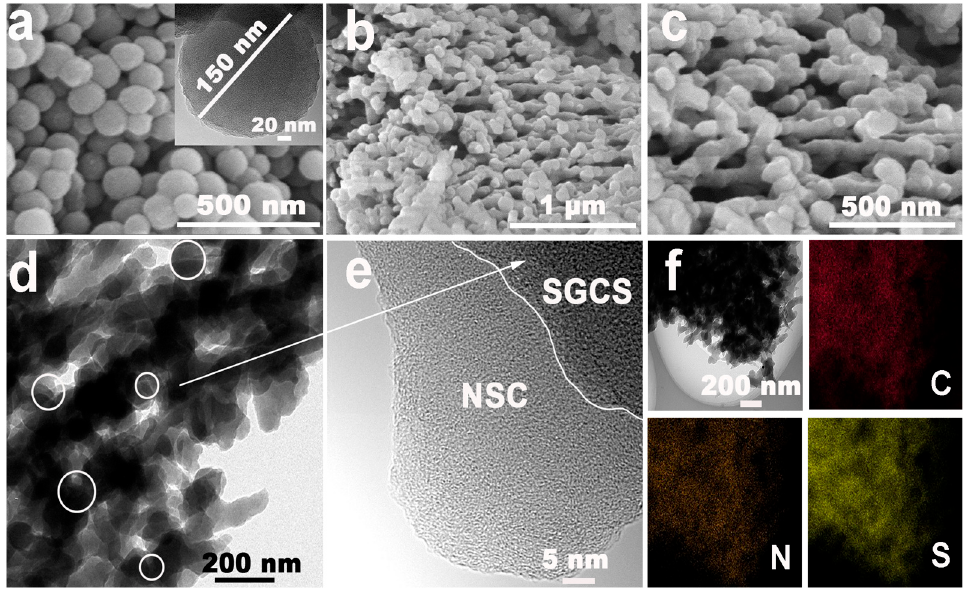
Figure 1 . ( a ) The SEM and TEM images of GCS. ( b , c ) The SEM images of SGCS@NSC. ( d , e ) The